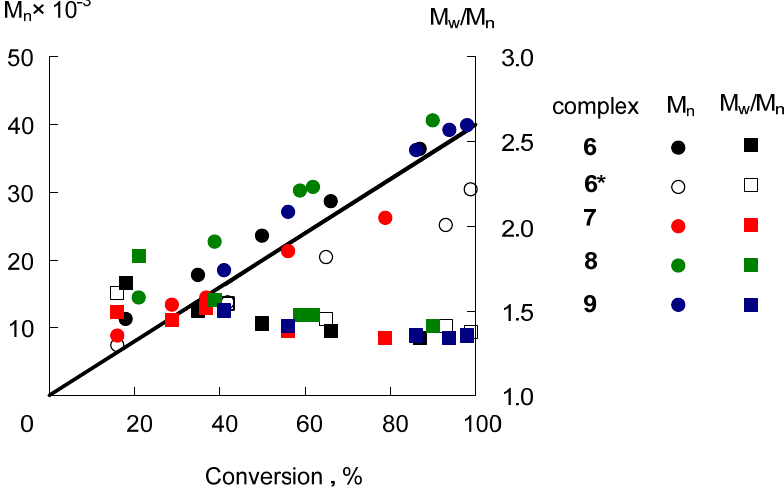
Figure 8. The dependences of number-average molecular weight (M n ) and dispersity (M w /M n ) of MMA samples obtained in the presence of ruthenacarboranes 6 – 9 at 80 ◦ C. [MMA]:[CCl 4 ]:[Ru]:[i-PrNH 2 ] = 10,000:25:1:40. *—[MMA]:[CCl 4 ]:[Ru]:[i-PrNH 2 ] = 10,000:25:2:40. Straight line—theoretically predicted values.